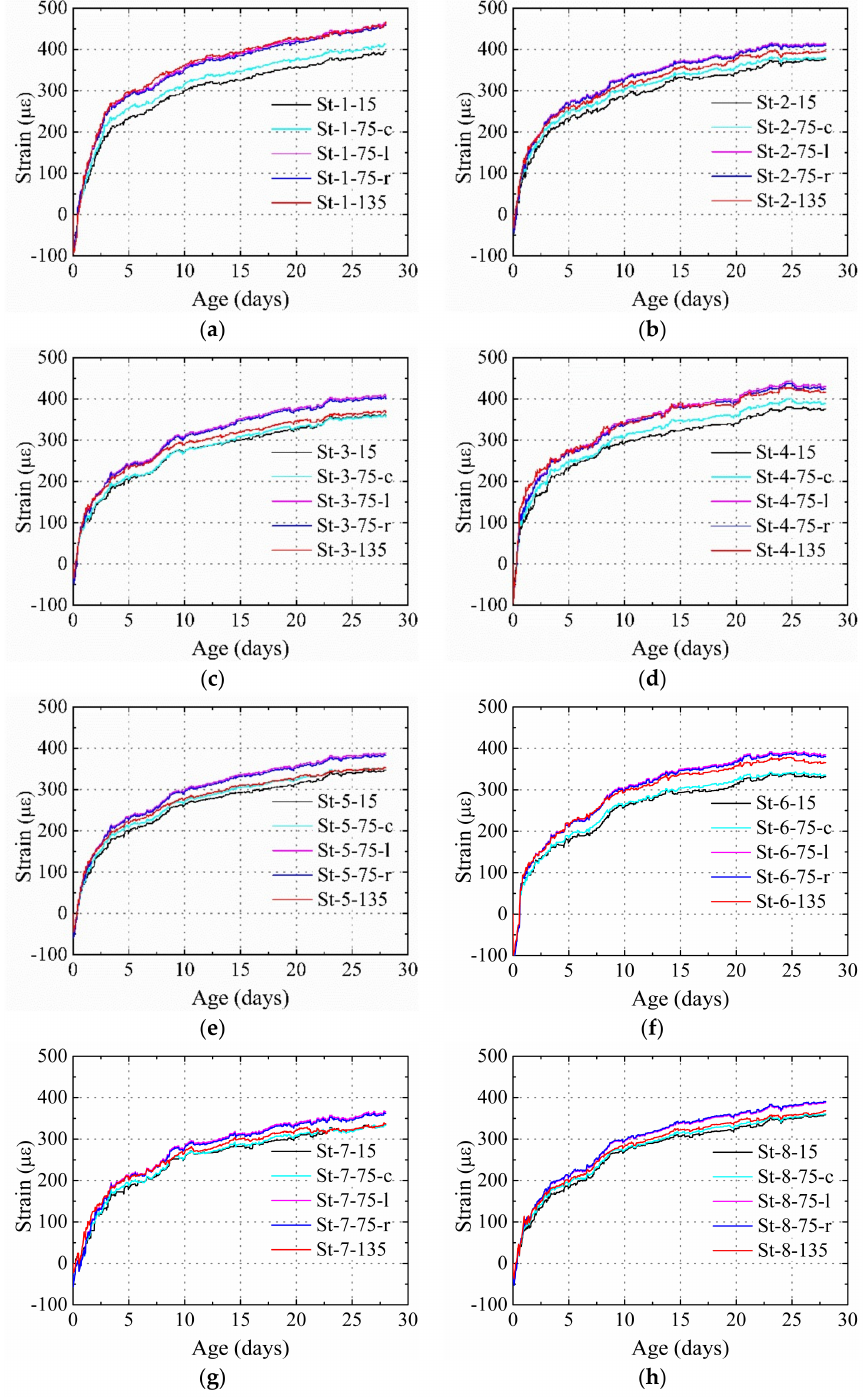
Figure 11. Measured strain for the specimens restrained by steel plate and stud: ( a ) St-1, ( b ) St-2, ( c ) St-3, ( d ) St-4, ( e ) St-5, ( f ) St-6, ( g ) St-7, and ( h )